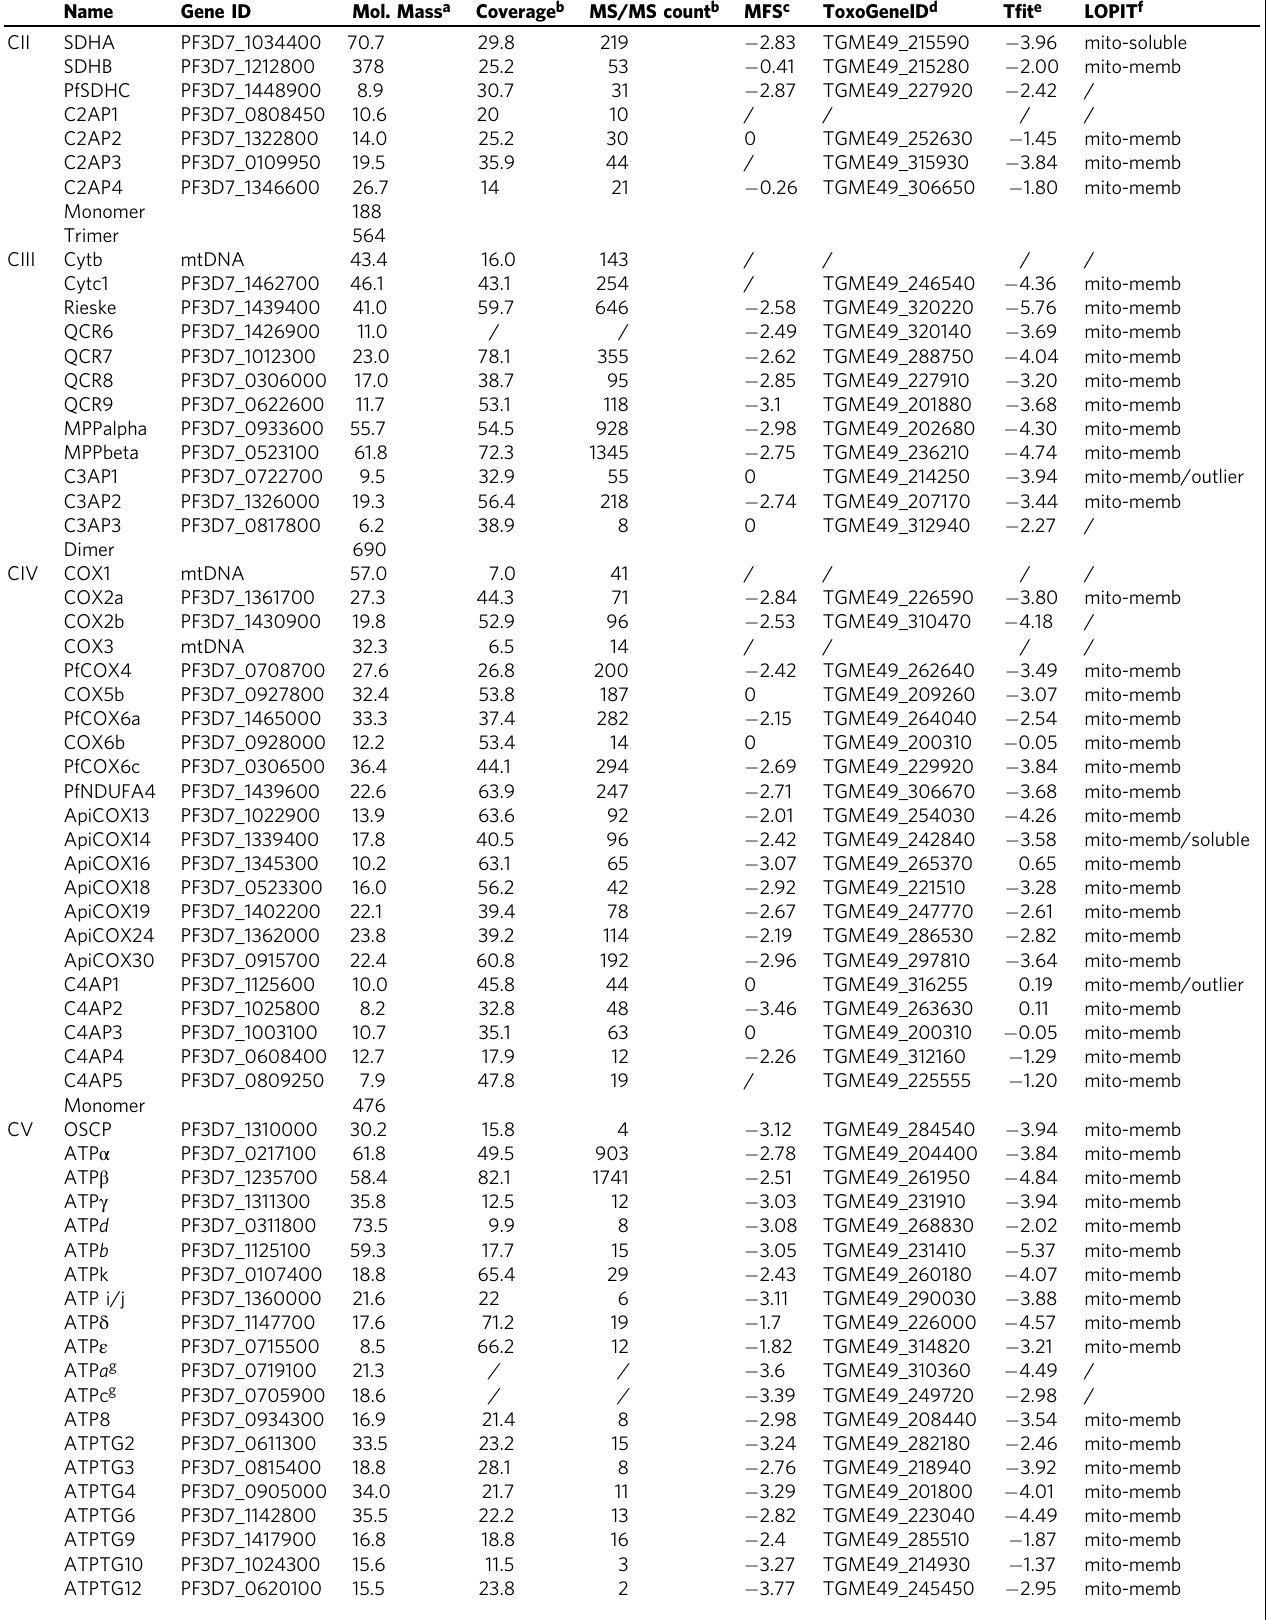
Table 1 Divergent composition of the respiratory chain complexes in Plasmodium falciparum